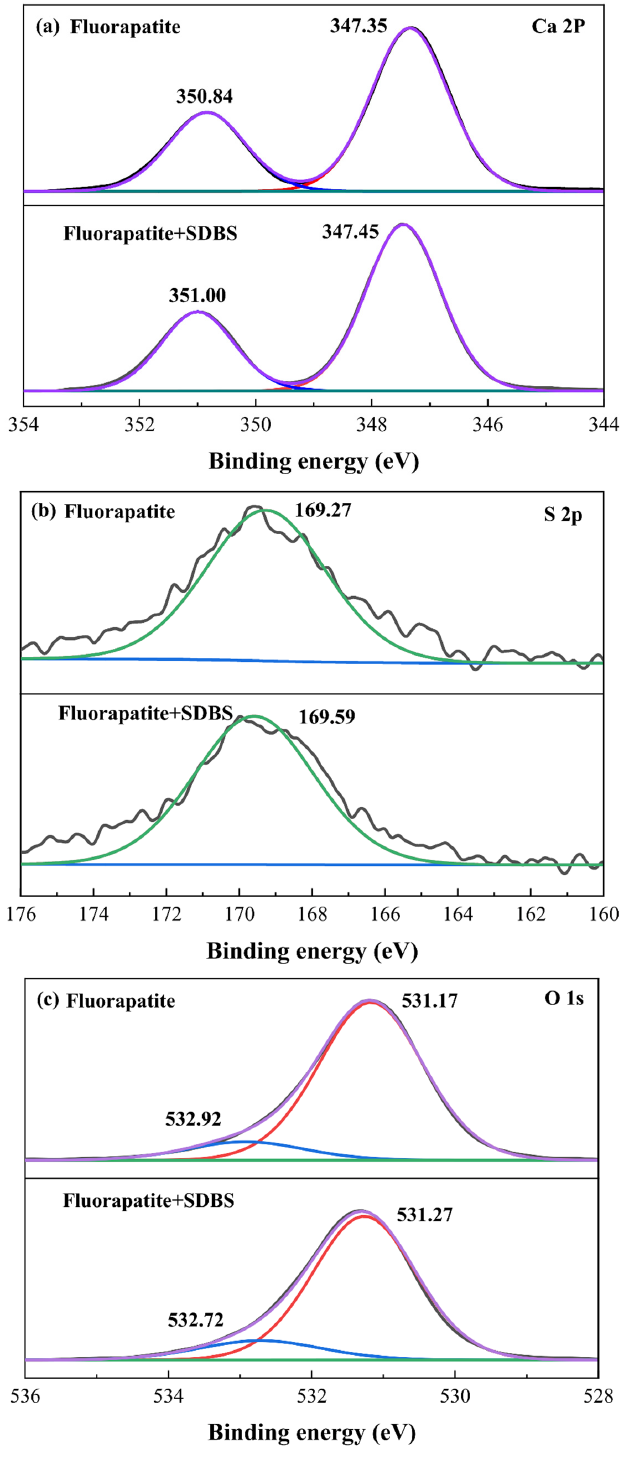
Figure 6. ( a ) Ca 2p, ( b ) S 2p, and ( c ) O 1s of fluorapatite sample with and without the addition of SDBS. As for dolomite, the S 2p, C 1s, Ca 2p, Mg 1s and O 1s XPS spectra were presented in Figure 7, respectively. From Figure 7a it can be seen that with and without the pretreatment of SDBS, there are no S peaks have been detected on dolomite surface, suggesting that the adsorption of SDBS on dolomite was weak. As depicted in Figure 7b, for untreated dolomite, three well-fitting bands at 284.86 eV, 286.17 eV, and 289.92 eV separated from the C 1s spectrum. The fitted bands at 284.86 eV and 286.17 eV on the dolomite